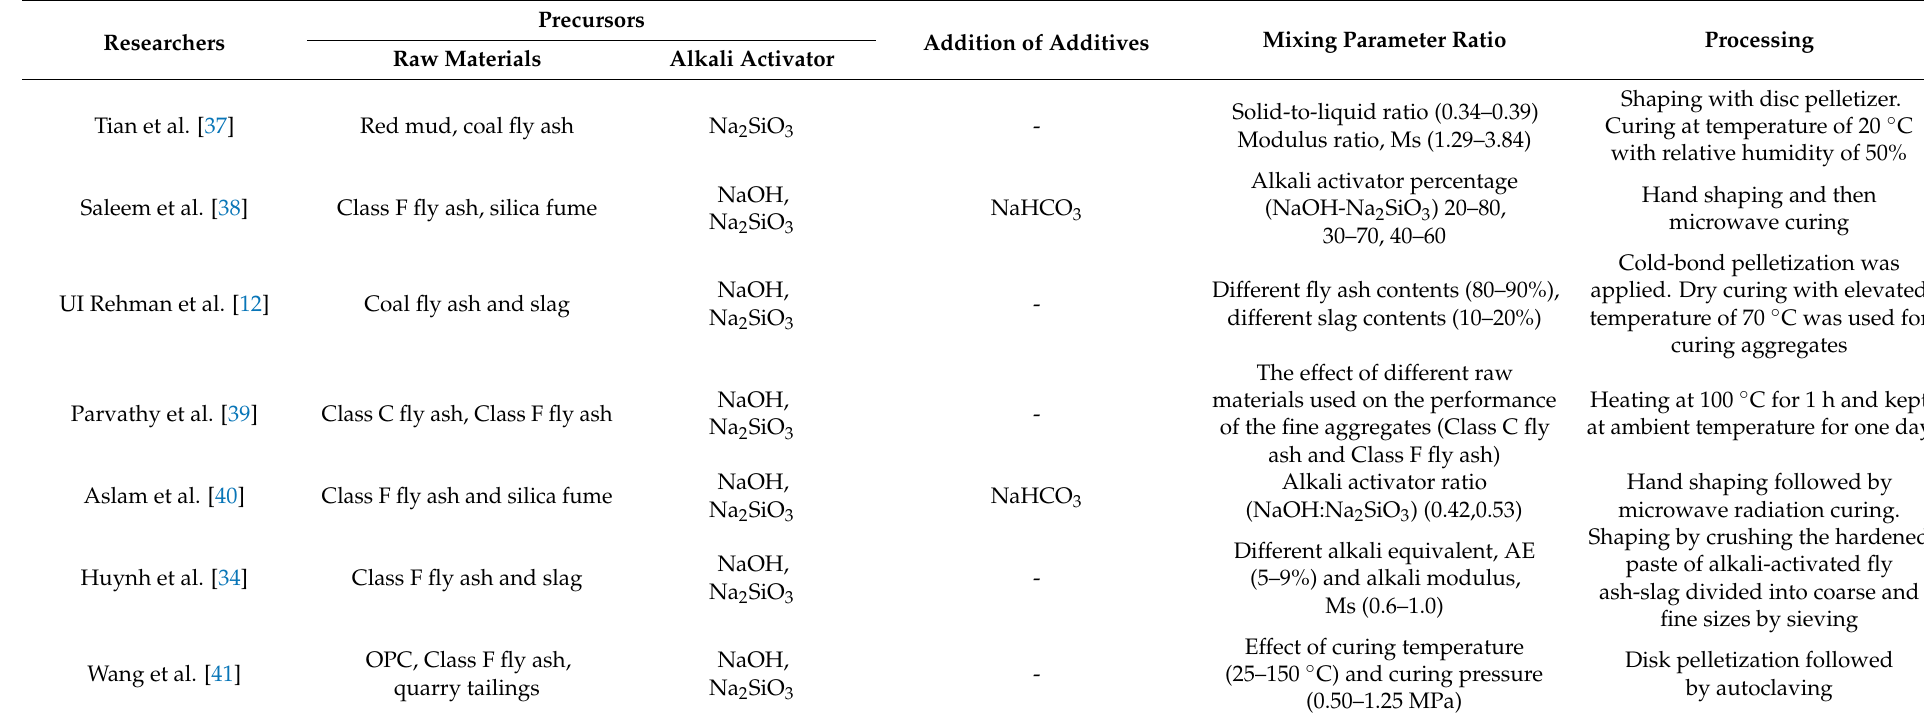
Table 1. Past research on Geopolymer-based Artificial Aggregates with different mixing parameter ratios and processing